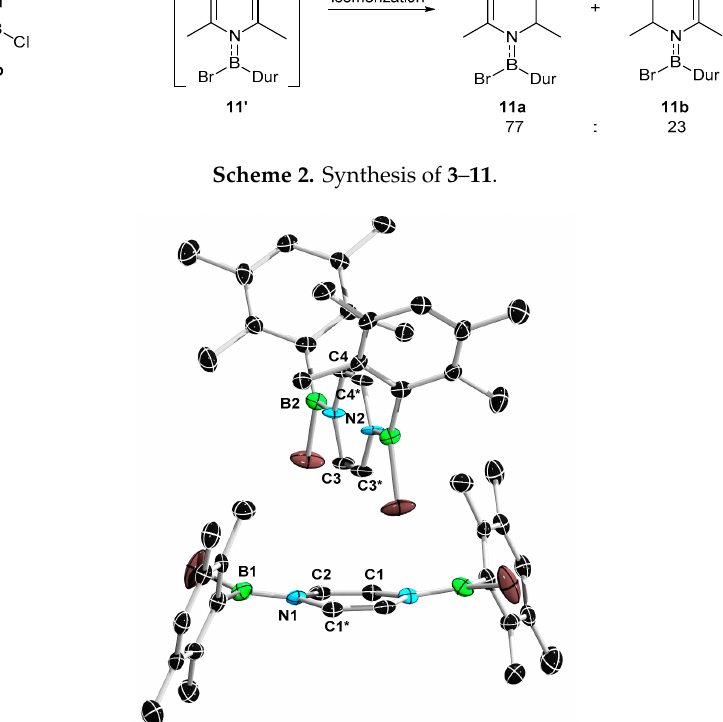
Figure 1. Molecular structures of 5a (bottom) and 5b (top) in the solid state (ellipsoids set at 50% probability). Hydrogen atoms are omitted for clarity. Selected bond lengths (Å) and angles (°) for 5a :